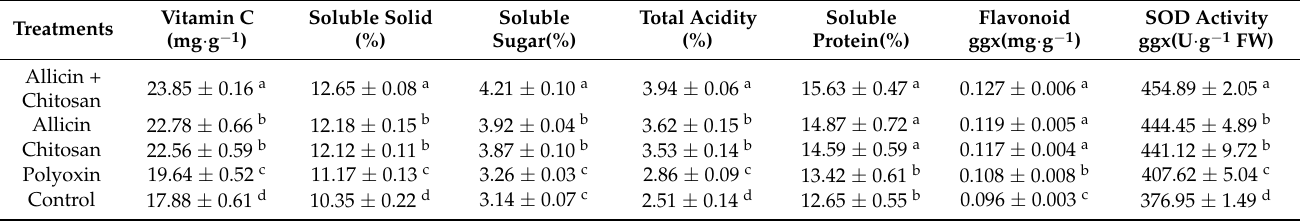
Values indicate the mean ± SD of three replicates. Different small letters indicate significant differences at 5% level ( p < 0.05).